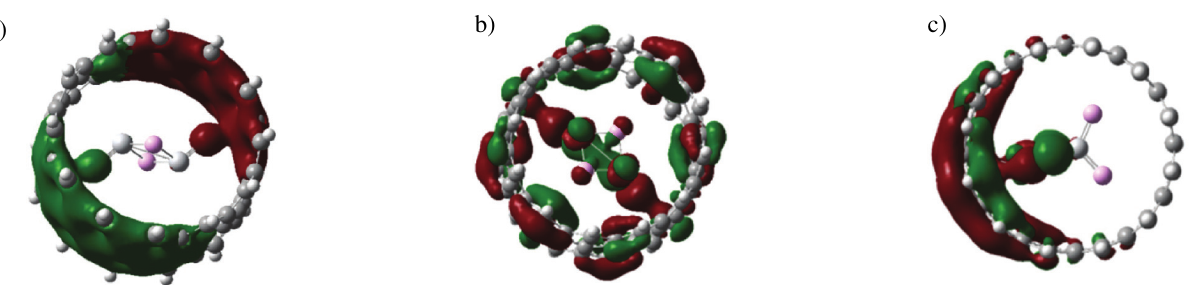
Figure 6 . Representations of molecular orbitals for TiO –0.31963au. Isoenergetic value is